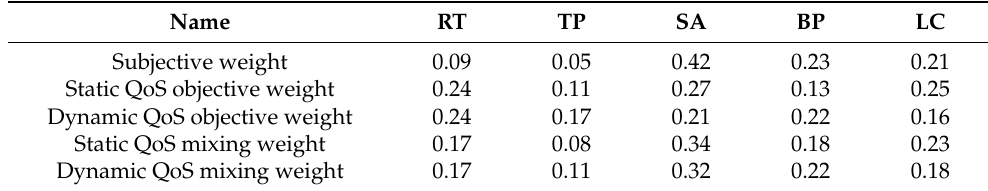
Table 4. Table 4. The values of various